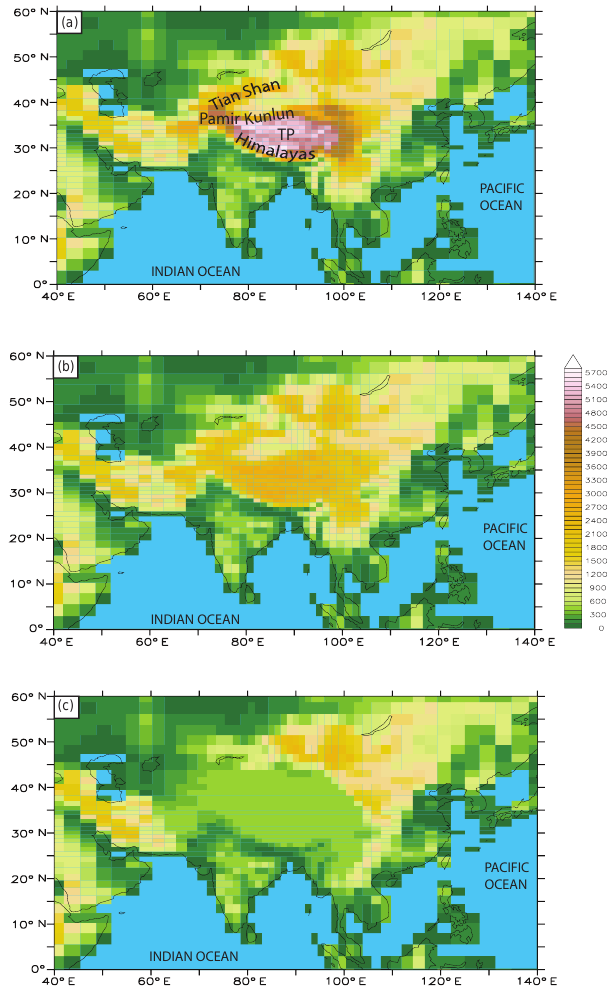
Figure 1. Models design (a) 100% of modern topography – MOD case; (b) Tibetan Plateau, Himalayas, Tian Shan, Pamir, Kunlun and Hindu Kush elevations reduced to 50% of modern elevation – INT case; (c) Tibetan Plateau, Himalayas, Tian Shan, Pamir, Kunlun and Hindu Kush elevations reduced to 250m – LOW case.